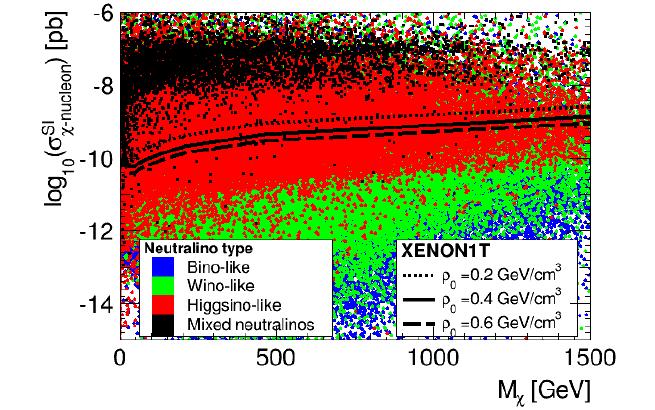
Figure 11 . Generalised spin-independent neutralino scattering cross section as a function of the neutralino mass. The lines show the XENON1T 90% C.L. upper limit for three di(cid:11)erent values of the local dark matter density (cid:26) 0